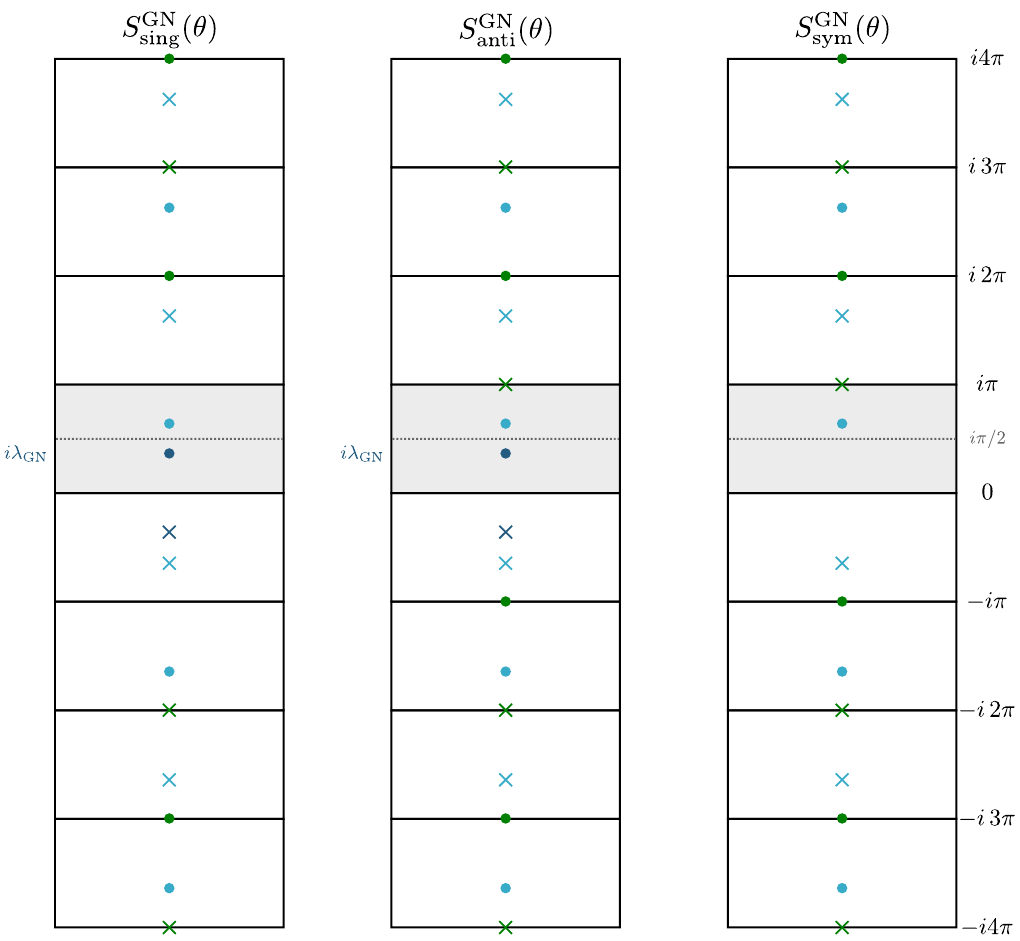
Figure 3 . Analytic structure of the Gross-Neveu S-matrix in the (cid:18) plane. The conventions are the same as in (cid:12)gure 2. The dark blue poles (cid:15) indicate the bound state poles in the singlet and anti-symmetric representations at (cid:18) = i(cid:21) GN = 2 (cid:25)= ( N (cid:0) 2). The lighter blue poles (cid:15) depict the t-channel poles at (cid:18) = i(cid:25) (cid:0) i(cid:21) GN . As explained in the main text, the Gross-Neveu and